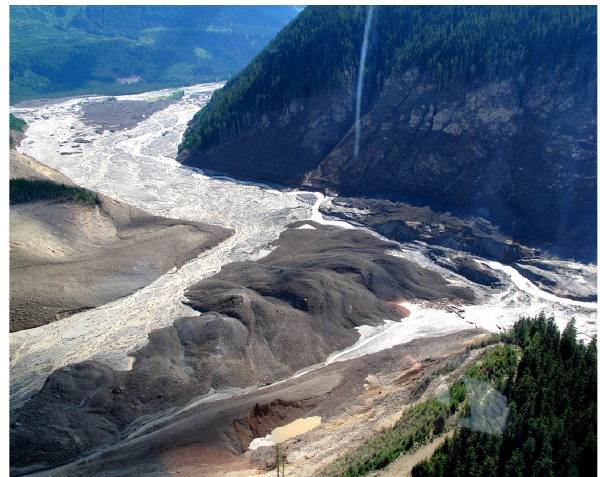
Fig. 13. The Meager Creek barrier after the dam outburst flood at the confluence of Capricorn and Meager